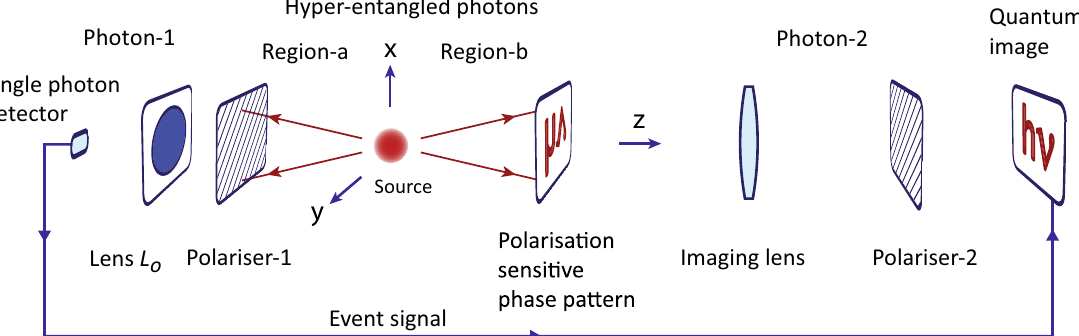
Figure 1. A schematic diagram of a quantum imaging experiment of a transparent polarisation sensitive phase pattern. A single photon-2 of a hyper-entangled photon pair is passed through the pattern. Polarisation state of each photon is measured by passing through polarisers. Photon-1 is measured in a particular quantum superposition of its position after its polarisation selection by passing through a lens L o followed by a detection by a single photon detector. An event signal produced by the single photon detector is sent to a single photon sensitive camera to detect a position of photon-2 corresponding to a particular measurement outcome of photon-1. An image is gradually formed by accumulating photon-2 detections on the camera by repeating the same